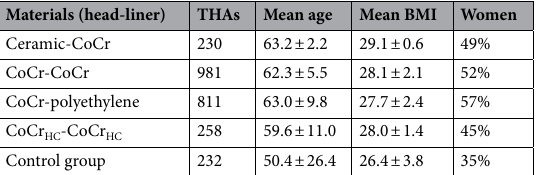
Table 2. Demographic of the patients of each group (CoCR: Co Cr; CoCR HC : CoCr—high carbid).